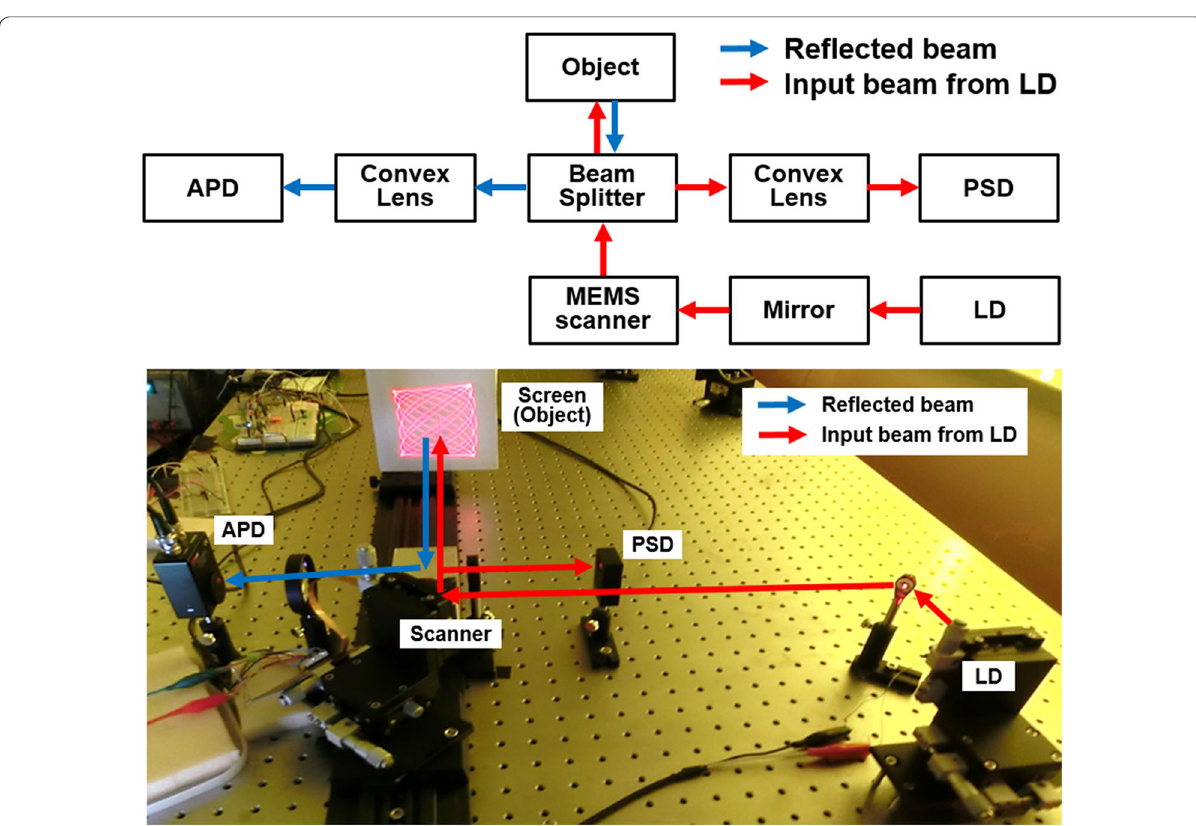
Fig. 2 Block diagram (top) and optical setup (bottom) of the distance measurement system (Lens in front of APD: 50.8 mm‑diameter, f 60, lens in front of PSD: 25.4 mm‑diameter, f